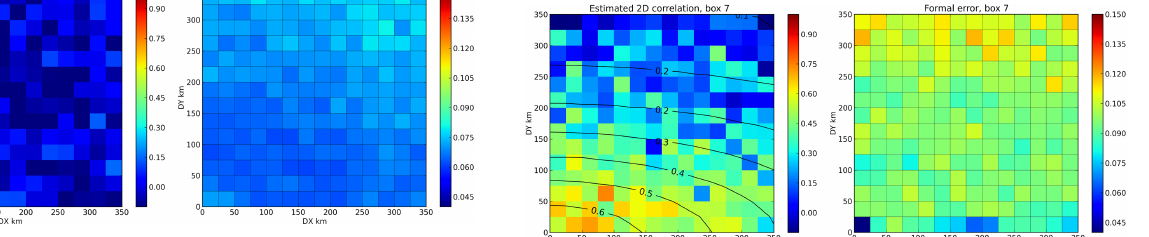
Figure 6. 2-D covariance calculated in a 100 ◦ × 20 ◦ area (box num- ber 7) in the equatorial Pacific Ocean (left) and associated formal error (right) for temperature at 200m. Black isolines correspond to the adjusted covariance